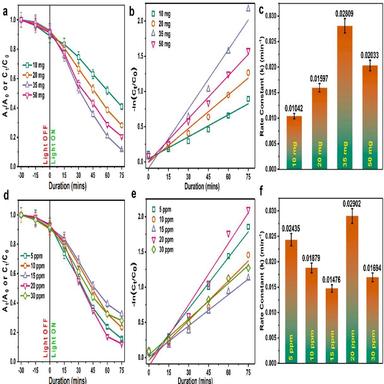
Evaluation of (a), (b), and (c) effect of AgFeO2/GO3 dosage on LMF degradation, and (d), (e), and (f) effect of LMF concentration on photodegradation efficiency.